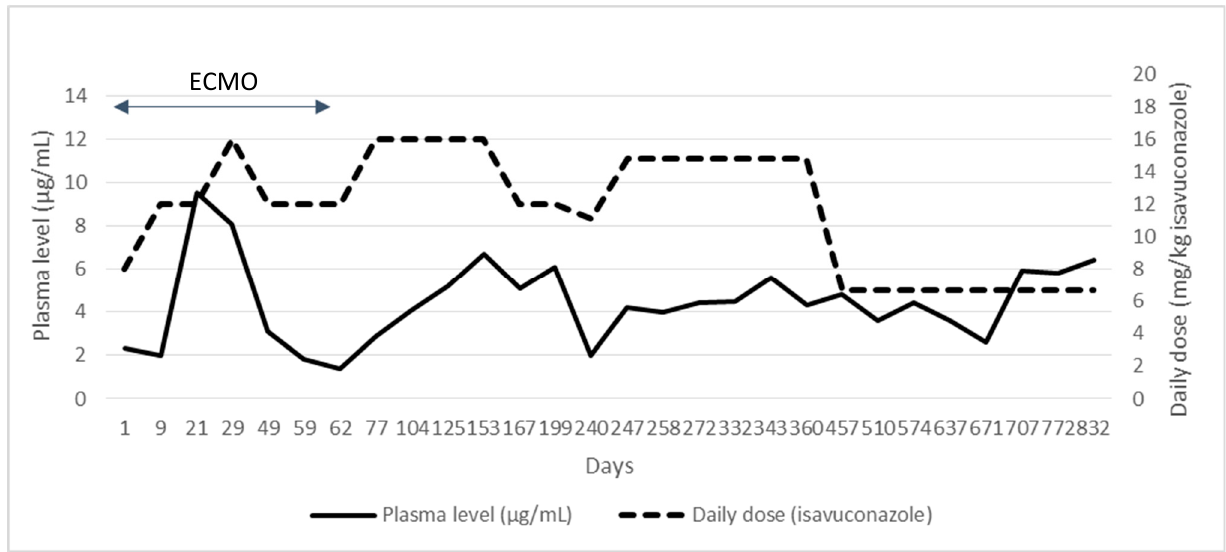
Figure 1. Plasma levels and isavuconazole dosage during the patient’s clinical evolution.